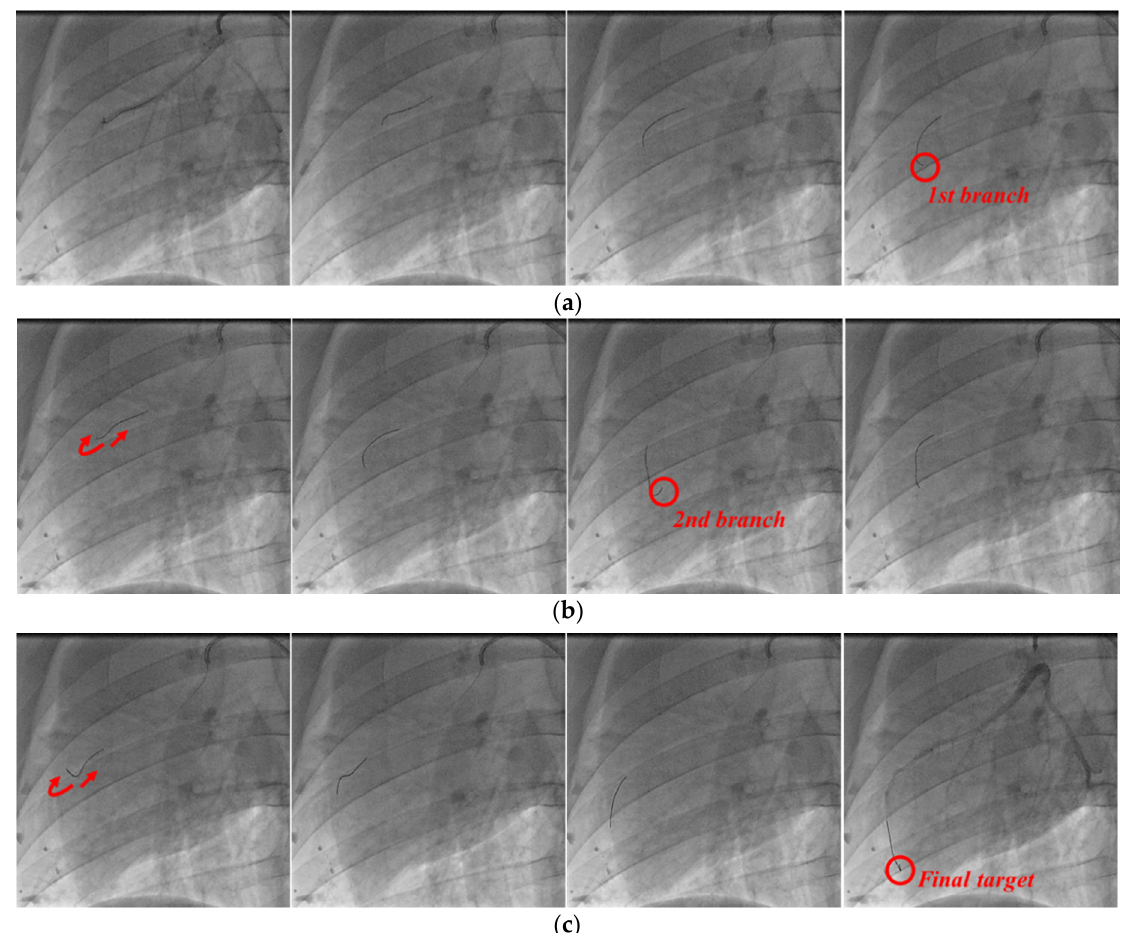
Figure 16. Angiographic views of the right coronary artery of the pig. Process of inserting guidewire into ( a ) first branch, ( b ) second branch, and ( c ) final target.